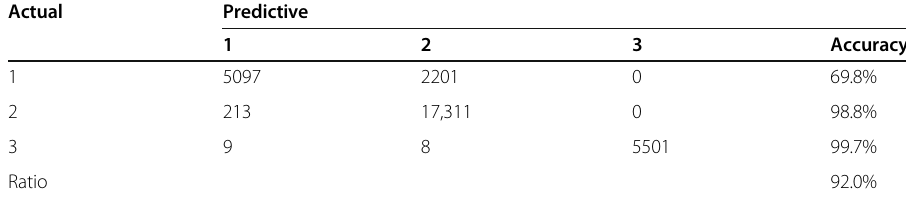
Table 2 Discriminatory analysis of the improved naive Bayes classification algorithm Actual